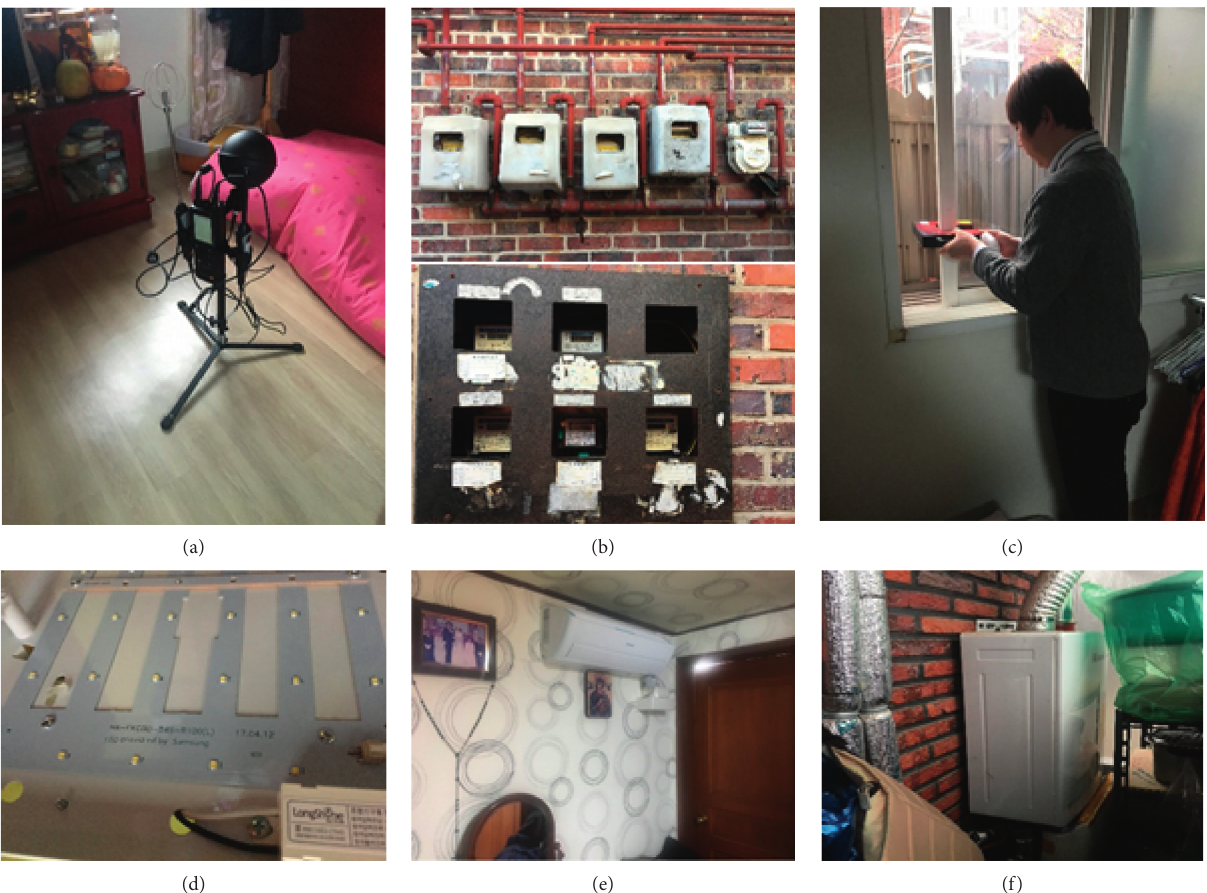
Figure 2: Field measurements in 70 low-rise residential buildings of Korea. (a) Indoor temperature. (b) Usage of electric, gas. (c) Window information. (d) Lighting. (e) Air conditioning. (f) Boiler